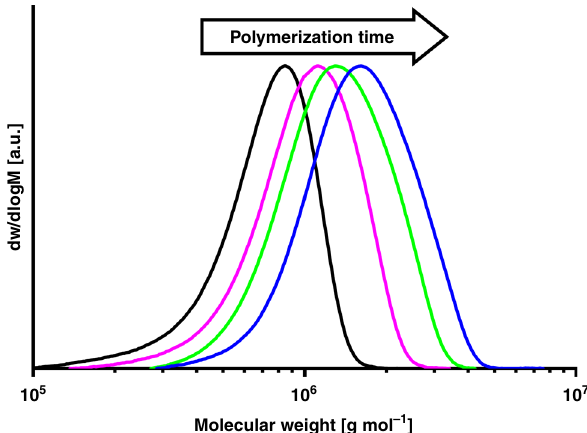
Fig. 5 GPC traces of narrow distributed UHMWPEs obtained in aqueous polymerization after different reactions times. Black curve: 0.5 hours reaction time, magenta curve: 1 h reaction time, green curve: 2 h reaction time, blue curve: 4 h reaction time (data from Table 2, entries 1 –